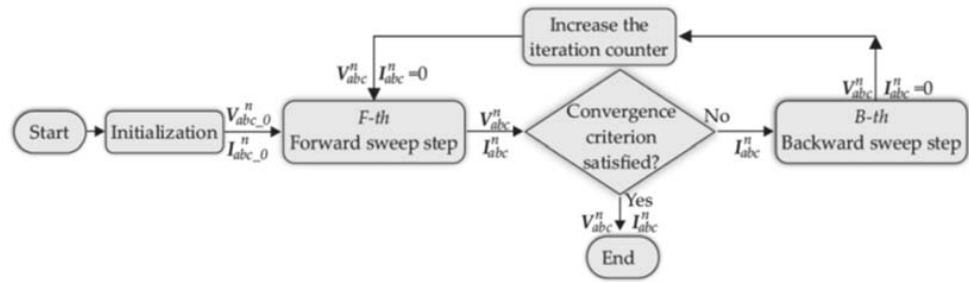
Figure 9. Flowchart of the FBS